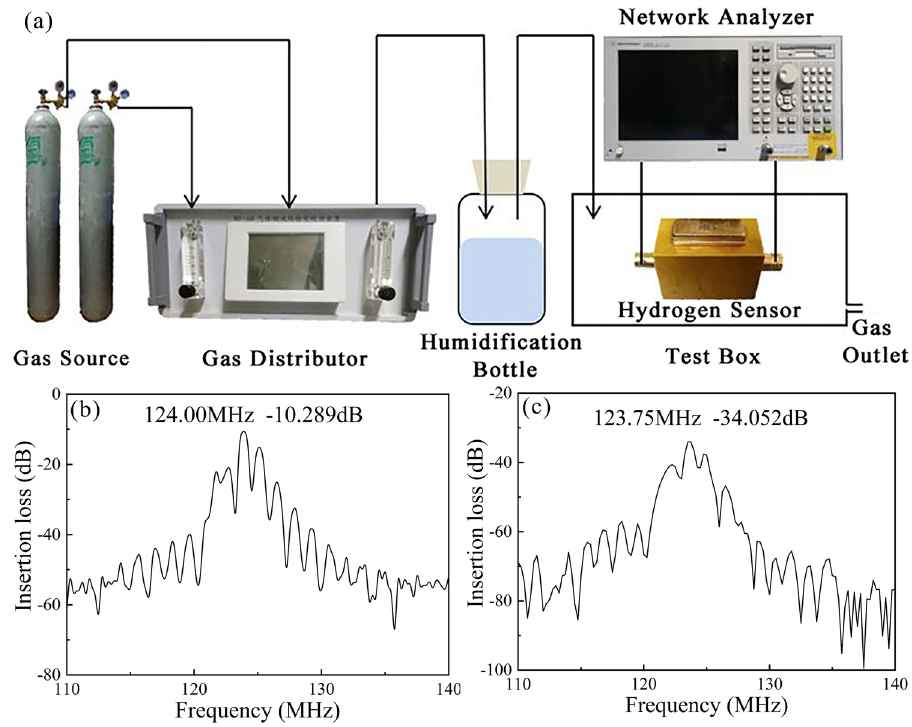
Figure 2. Experimental system. ( a ) Experimental apparatus for H 2 sensing. ( b , c ) Frequency responses of the ultrasonic H 2 sensor measured ( b ) before and ( c ) after depositing the sensitive